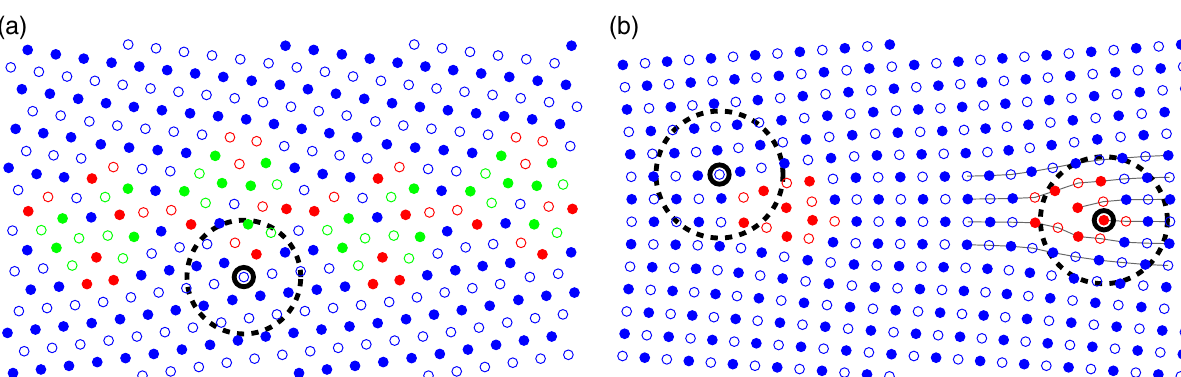
Fig. 5 Illustration of important LAEs for classifying thermally activated GB mobility, as identi fi ed in two different GBs. The GB shown in a is a (cid:4) (cid:5) Σ 51a (16.1° symmetric tilt about the [110] axis, 1110 boundary planes) GB, and has one LAE identi fi ed. The LAE shown in a has a relative importance of 3% over the entire system and includes a leading partial dislocation that originates from the GB. The GB shown in b is a Σ 85a (cid:4) (cid:5) (8.8° symmetric tilt about the [100] axis, 0113 boundary planes) GB, and has two LAEs identi fi ed. The leftmost LAE has a relative importance of 9% (for all GBs in the data set) but its structural importance is not immediately clear, offering an exciting opportunity to discover new physics. The second LAE in b encloses edge dislocations, which are regularly spaced to form a tilt GB, (relative importance of 2.7% across all GBs). The open and fi lled circles denote atoms on the two unique stacking planes along the [100] or [110] direction. The atoms are colored according to common neighbor analysis (CNA) such that blue , green , and red atoms have a local environment that is FCC, HCP, or unclassi fi